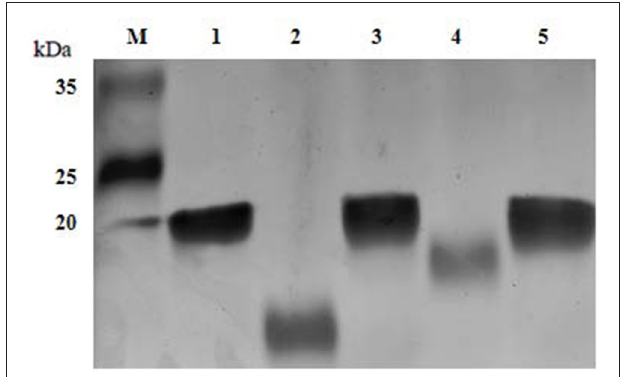
FIGURE 3 | LOS profiles of H. parasuis SC096 strain, mutants, and complemented strains. Lane 1, wild-type SC096; Lane 2 and 3, 1 lgtB and its complemented strain 1 lgtB -c; Lane 4 and 5, 1 lex-1 and its complemented strain 1 lex-1 -c.